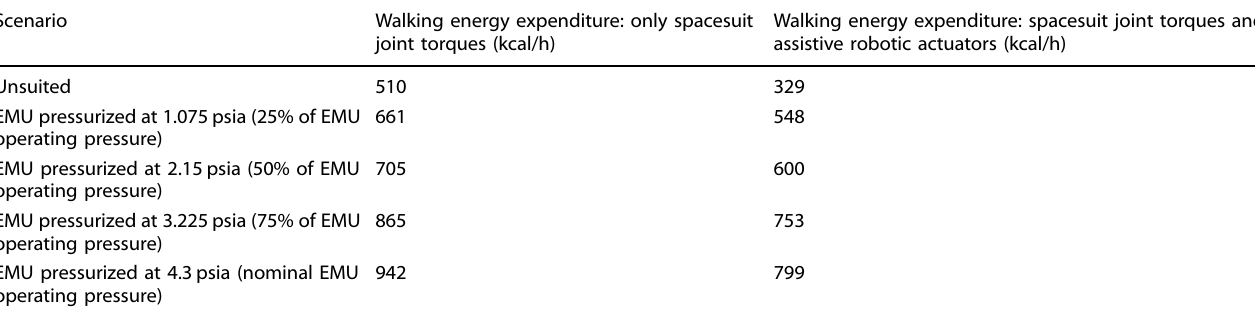
Table 1. Walking energy expenditure from biomechanical simulations of EMU-suited walking motion, with and without soft-robotic actuators (up to 10 N of assistive torque).